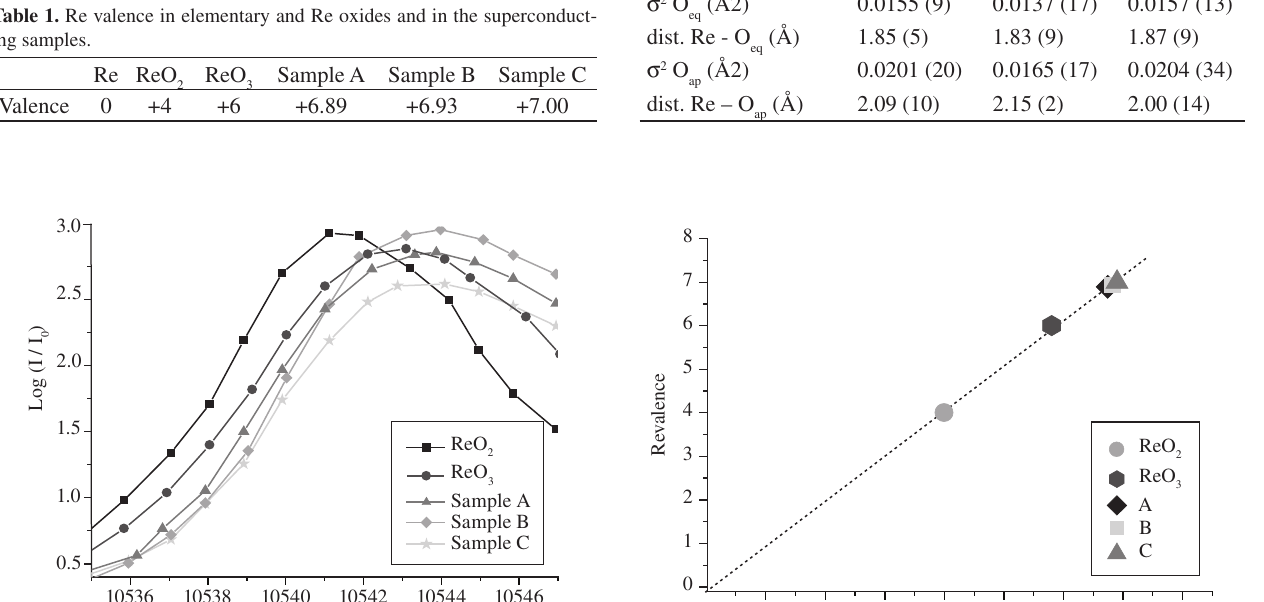
absorption edges in ReO , ReO oxides and in the samples A, B and C; and b) valences of Re in the samples of the Hg,Re- III 2 3